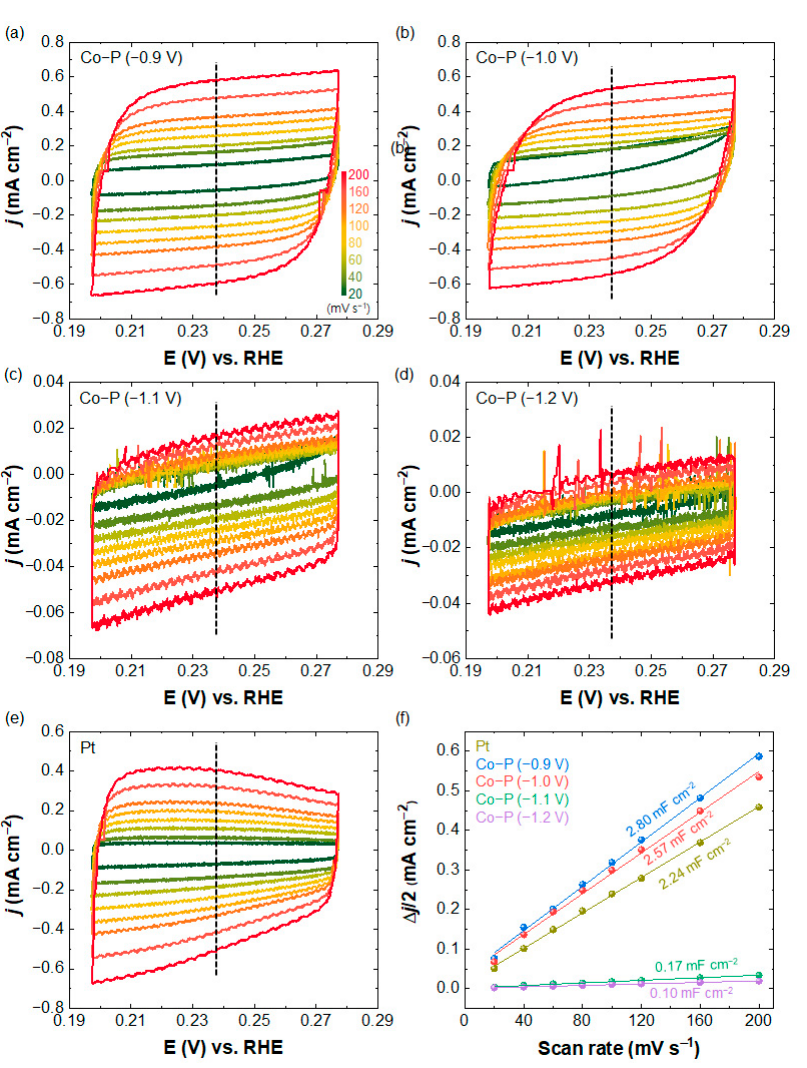
Figure 4. CV curves of ( a – d ) Co-P and ( e ) Pt electrocatalysts prepared at various applied potentials. Scan rates were controlled in the range of 20–200 mV s − 1 . ( f ) Calculated C dl for Co-P and Pt electrocatalysts at j a and j c of 0.237 V vs. RHE (marked as dashed lines in the cyclic voltammograms of ( a – e )).